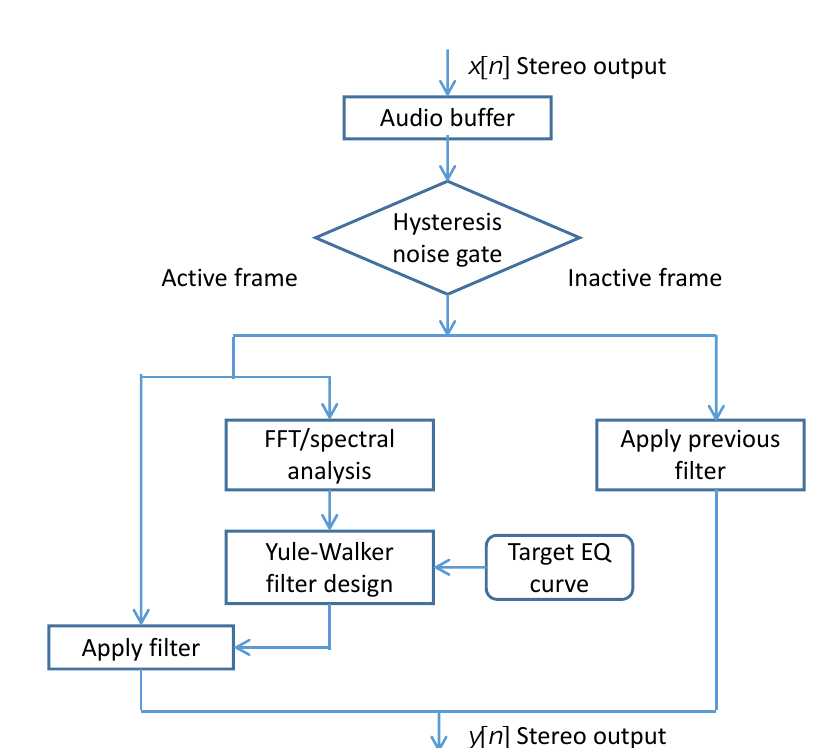
Figure 18. Block diagram of the real-time targeted equalization